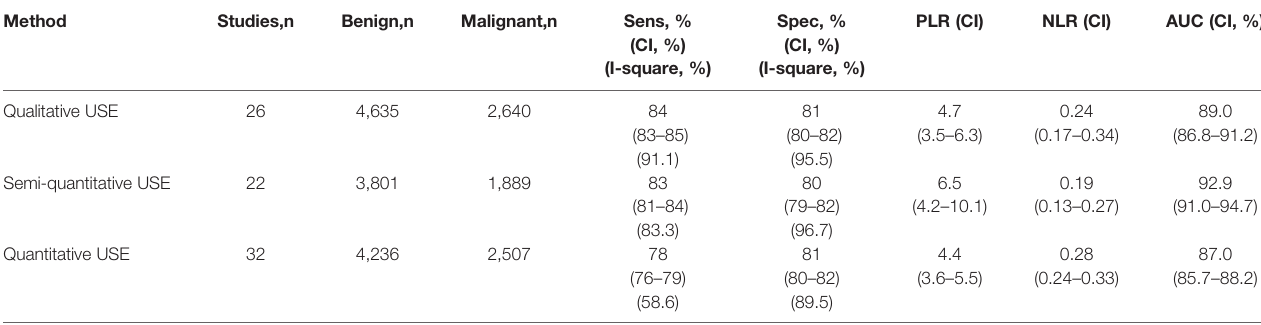
TABLE 4 | Diagnostic performance of each USE